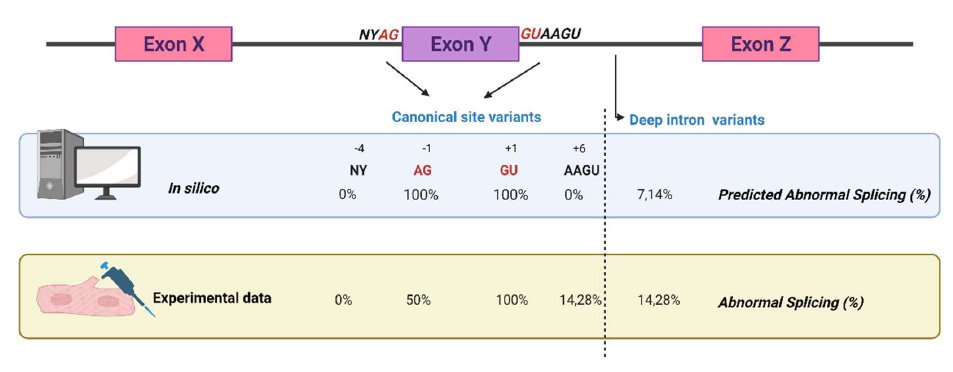
Figure 4. Representation of predicted abnormal splicing vs. experimentally shown. Canonical variants are represented based on their location (−3/4 and −1/2 for acceptor sites and +1/2 and +3/6 for donor sites). Deep intron variants include all variants beyond acceptor and donor consensus sites).